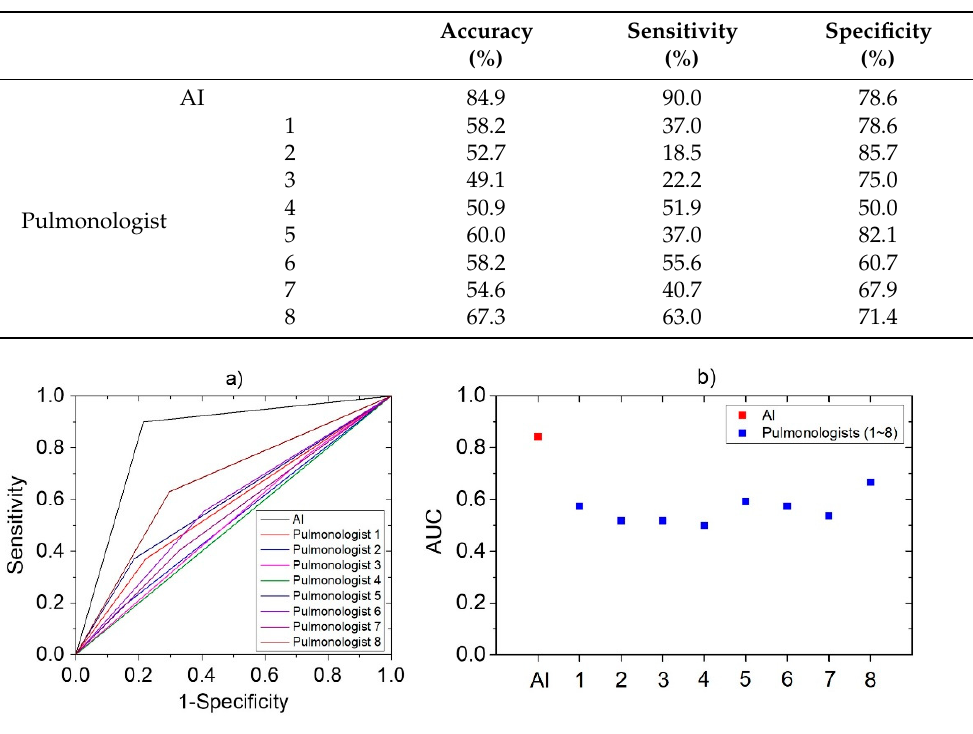
Figure 5. The statistical analysis derived by logistic regression models based on the pneumonia di ‐ agnostic results of AI and pulmonologists: ( a ) ROC Curve; ( b )